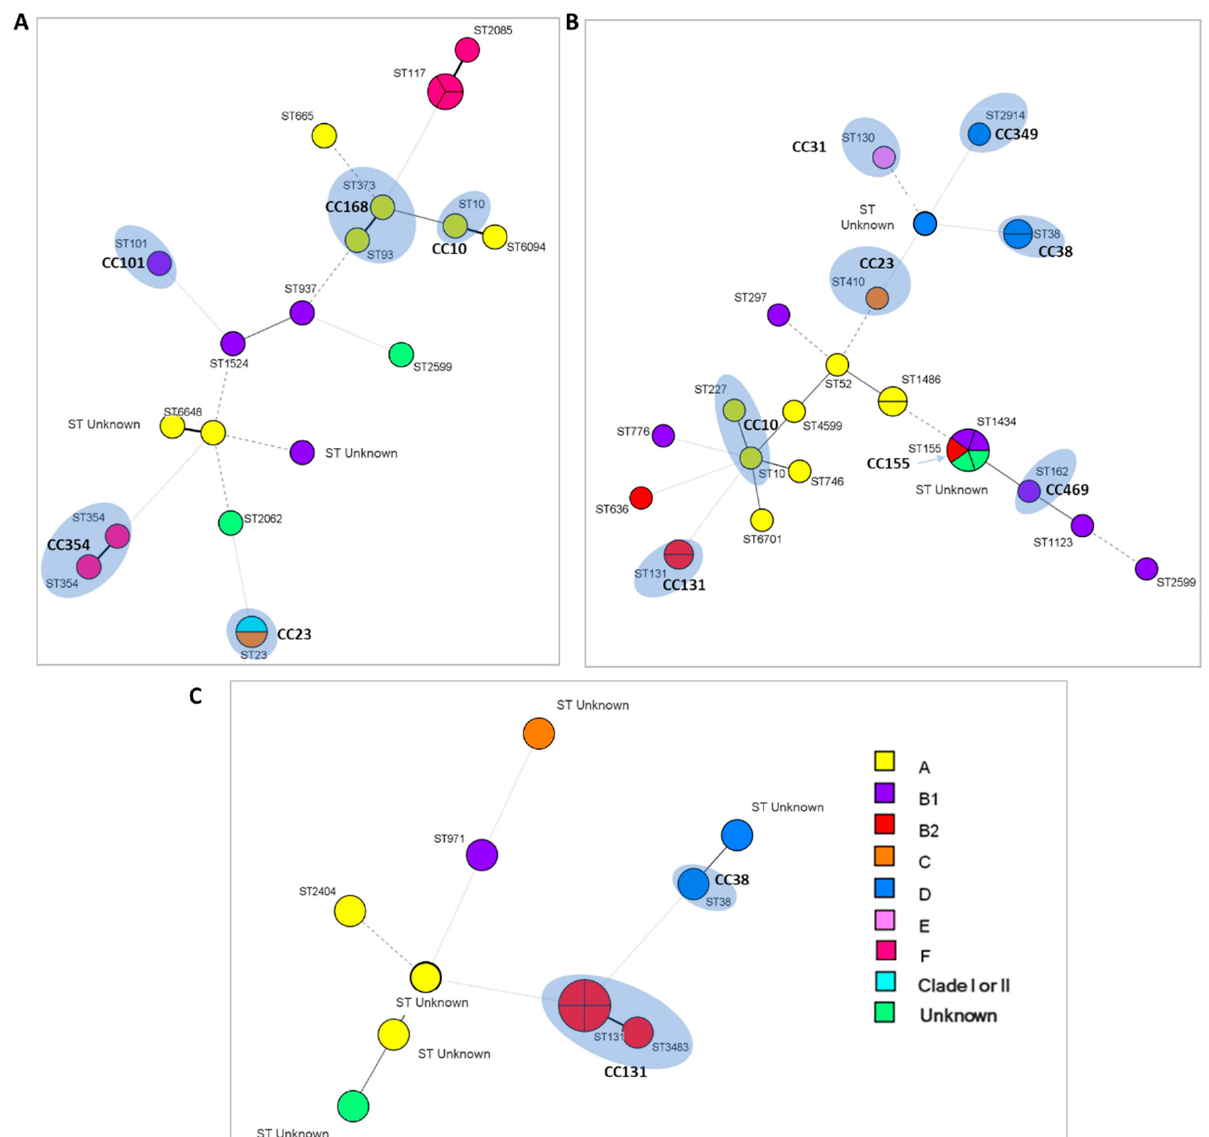
Figure 3. Clonal composition by MST of E. coli strains isolated from ( A ) food, ( B ) water and ( C ) healthy carriers. Each circle corresponds to an ST, its size being proportional to the number of isolates. The color of the circles indicates the phylogroup to which each isolate belongs, as indicated in the legend. The shaded areas indicate the detected CCs that group different STs. The union lines between the different nodes (bold, continuous, dashed or dotted lines) show the number of discordant alleles between the profiles of the strains (1, 2, 3 and 4 alleles, respectively).